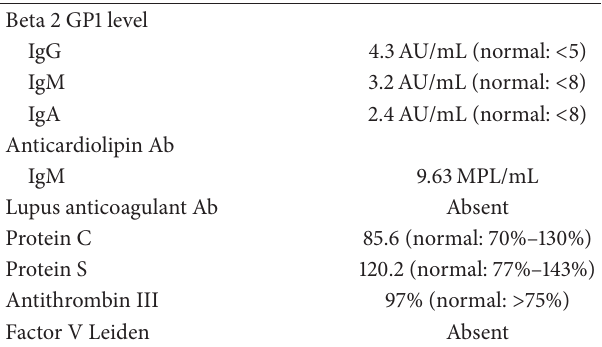
Table 1: Laboratory